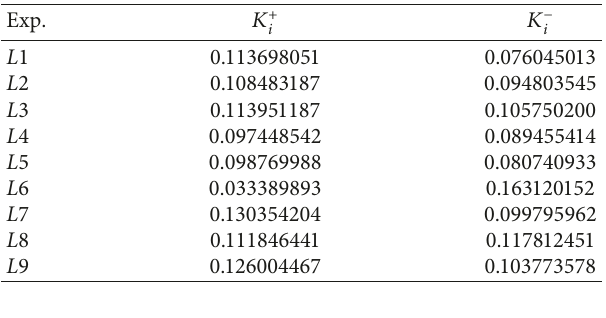
Table 18: Euclidian distance between the ideal ( B + Exp.